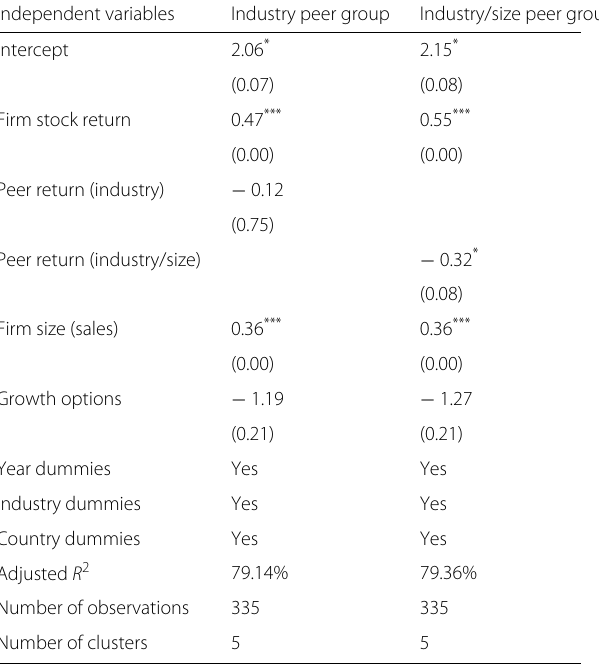
Table 17 Regressions estimating the sensitivity of